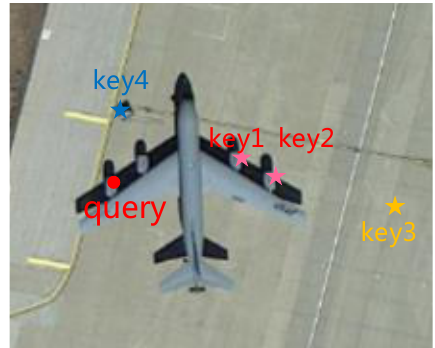
Figure 3. Schematic diagram of the correlation between query and